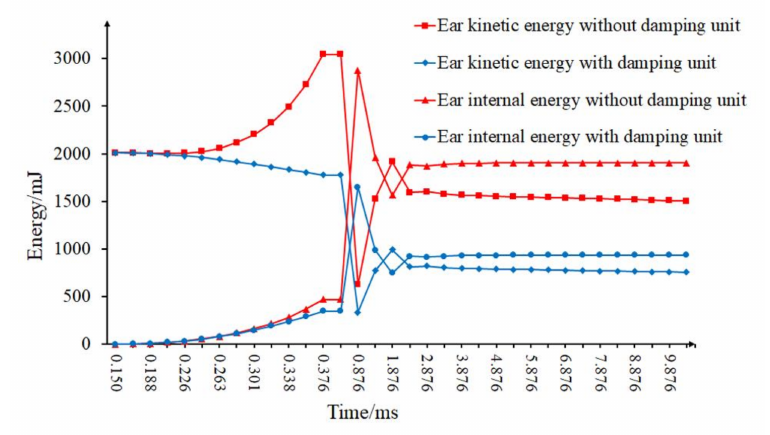
Figure 10. Ear energy